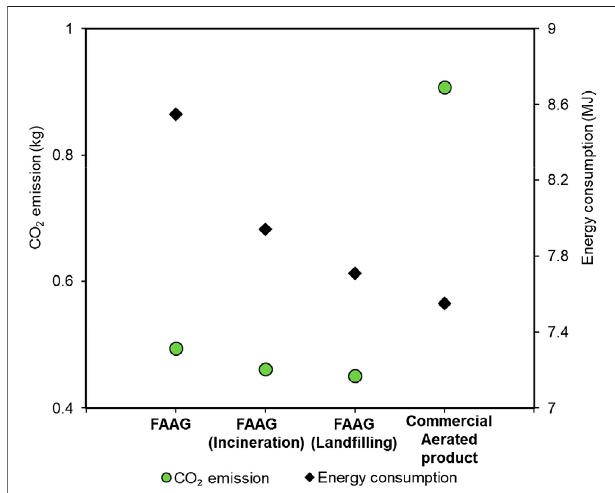
FIGURE 12 | CO 2 emissions and energy consumptions related to the preparation of 1 kg foamed alkali-activated glass (FAAG) considering impacts of waste glass proposal and 1 kg commercial aerated products.